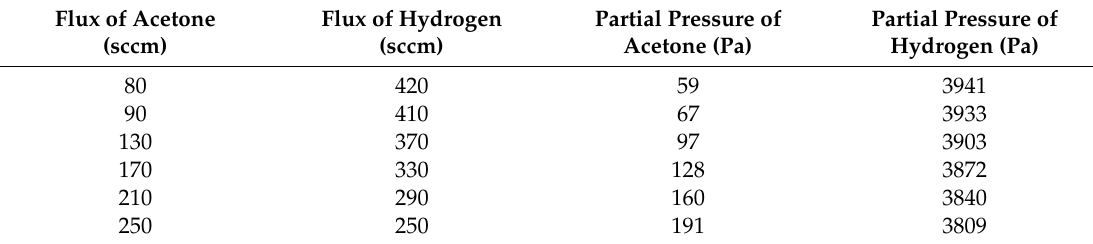
Table 1. Acetone and hydrogen fluxes and their partial pressures.